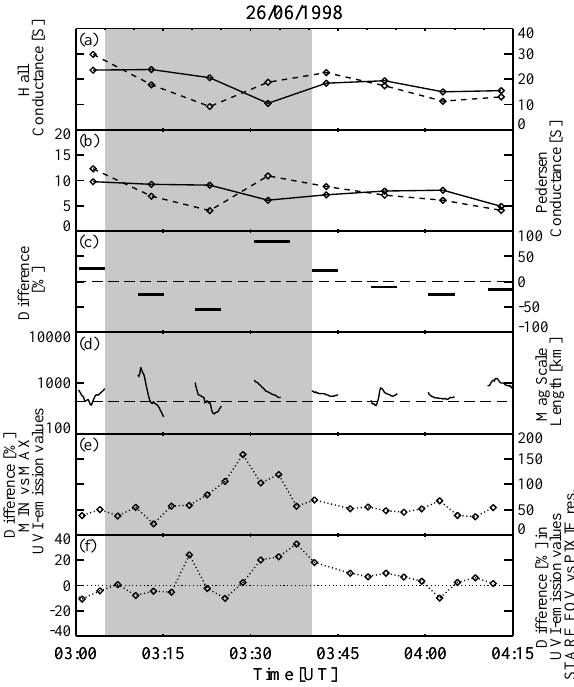
Fig. 6. ( a ) The Hall and ( b ) Pedersen conductances [S] derived in the Scandinavian region using UVI and PIXIE measurements (solid line) and the 1-D method of characteristics (dashed line) on 26 June 1998. ( c ) The difference in % between the two conductance sets. The horizontal dashed line is drawn to give the 0-percent level, while the length of the lines indicates the integration time period. ( d ) Magnetic field scale lengths (km) between the two MIRACLE magnetometer stations of AND and KEV. ( e ) The average percent- age calculated using the lowest and largest UVI-LBHL emission values at four strips of constant latitude within the STARE FOV. ( f ) The difference in % for the average UVI-LBHL intensity within the STARE FOV compared with the average UVI-LBHL intensity when including a larger area surrounding the STARE FOV match- ing the PIXIE